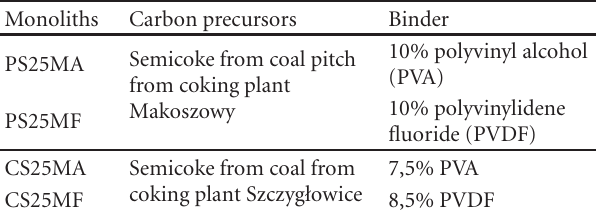
Table 1: Raw material characteristic of monoliths.